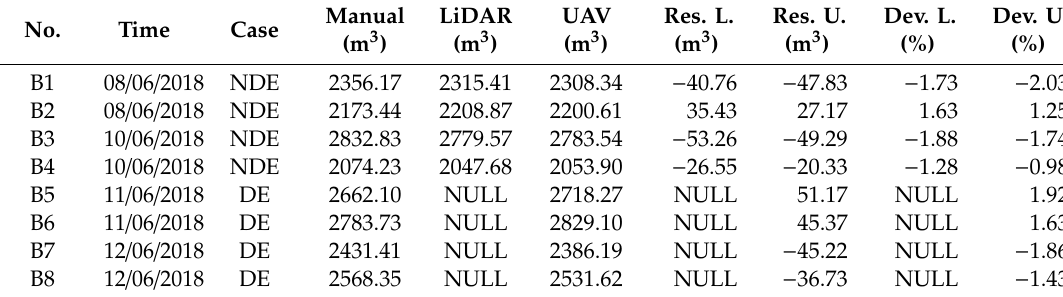
Table 6. Comparisons of volume calculation using traditional manual measurement (Manual), laser scanning (LiDAR), and UAV photogrammetry (UAV). B1–B8 denote the number of barges; DE and NDE denote the case of dynamic and non-dynamic environments, respectively; Res. L.: the residuals between LiDAR and Manual; Res. U.: the residuals between UAV and Manual; Dev. L.: the percentage of deviation calculated by dividing Res. L. by Manual; Dev. U.: the percentage of deviation calculated by dividing Res. U. by Manual; NULL: the invalid data in the dynamic environment.